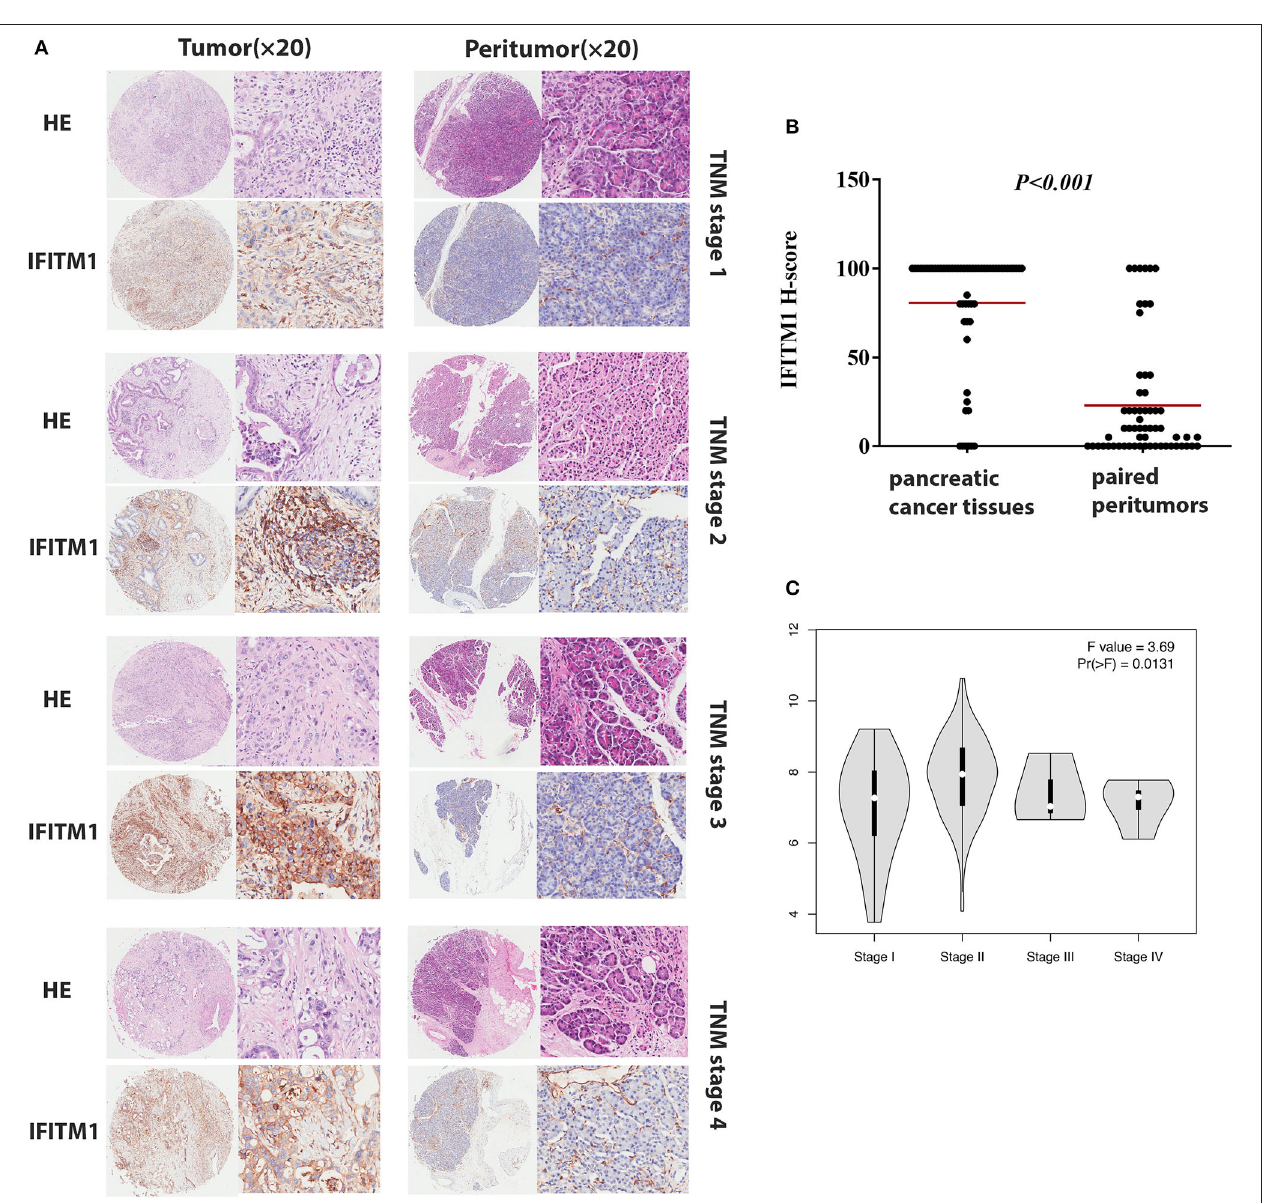
FIGURE 5 | The IFN-induced transmembrane protein 1 (IFITM1) expressions in pancreatic cancer samples and paired peritumor tissues. (A) IFITM1 in representative cases of pancreatic cancer tissues in TNM stage 1–4 were detected by IHC experiments, respectively. Original magnification × 20. (B) The differential protein expression of IFITM1 was shown in pancreatic cancer tissues and matched non-tumor tissues of 90 patients as indicated. The median extents of the expressions were indicated by the horizontal line in the scatterplot figure. (C) Correlations between different expressed IFITM1 and the pathological TNM stage of pancreatic cancer